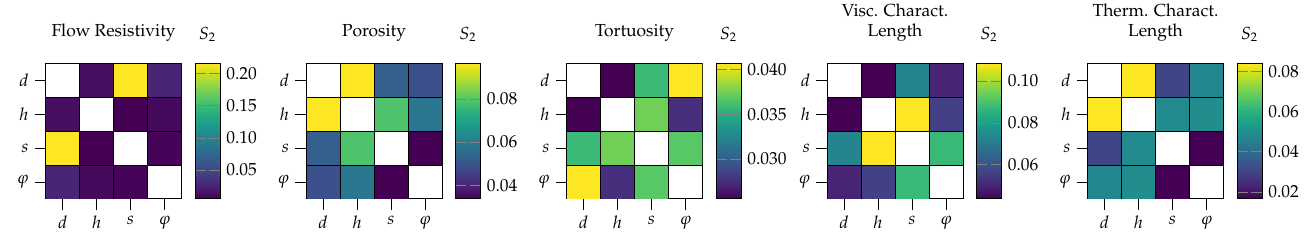
Figure 7. Second-order sensitivity coefficients of the porous material. The letters denote the geometry parameters as: d : bar width, h : bar height, s : bar spacing, ϕ : plane